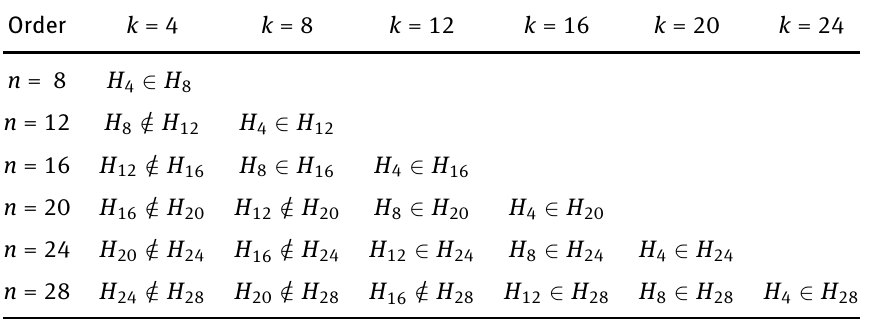
Table 2: Embeddability of Hadamard matrices H n − k for 4 ≤ k ≤ 24 and 8 ≤ n ≤ 28 .